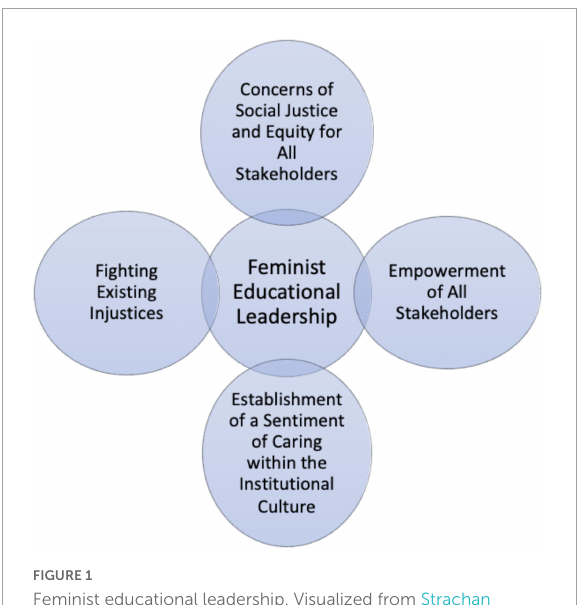
FIGURE1 Feminist educational leadership. Visualized from Strachan